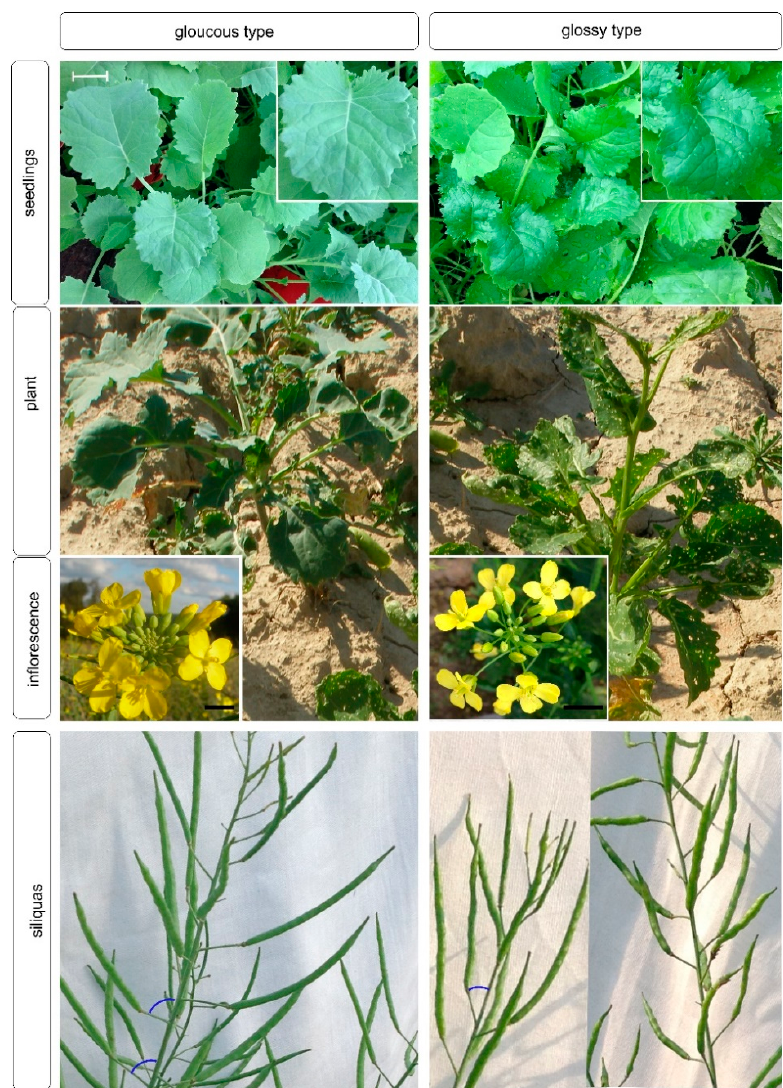
Figure 3. Phenotypic features of glossy and glaucous plants. Seedlings aged 14 days. Glossy plant of line 1168. Glossy plant siliques under “wet” condition (left) and dry (right). The leaves, shoots, and pods of glossy plants are distinguished not only by the absence of a waxy bloom but also by the yellowish color.